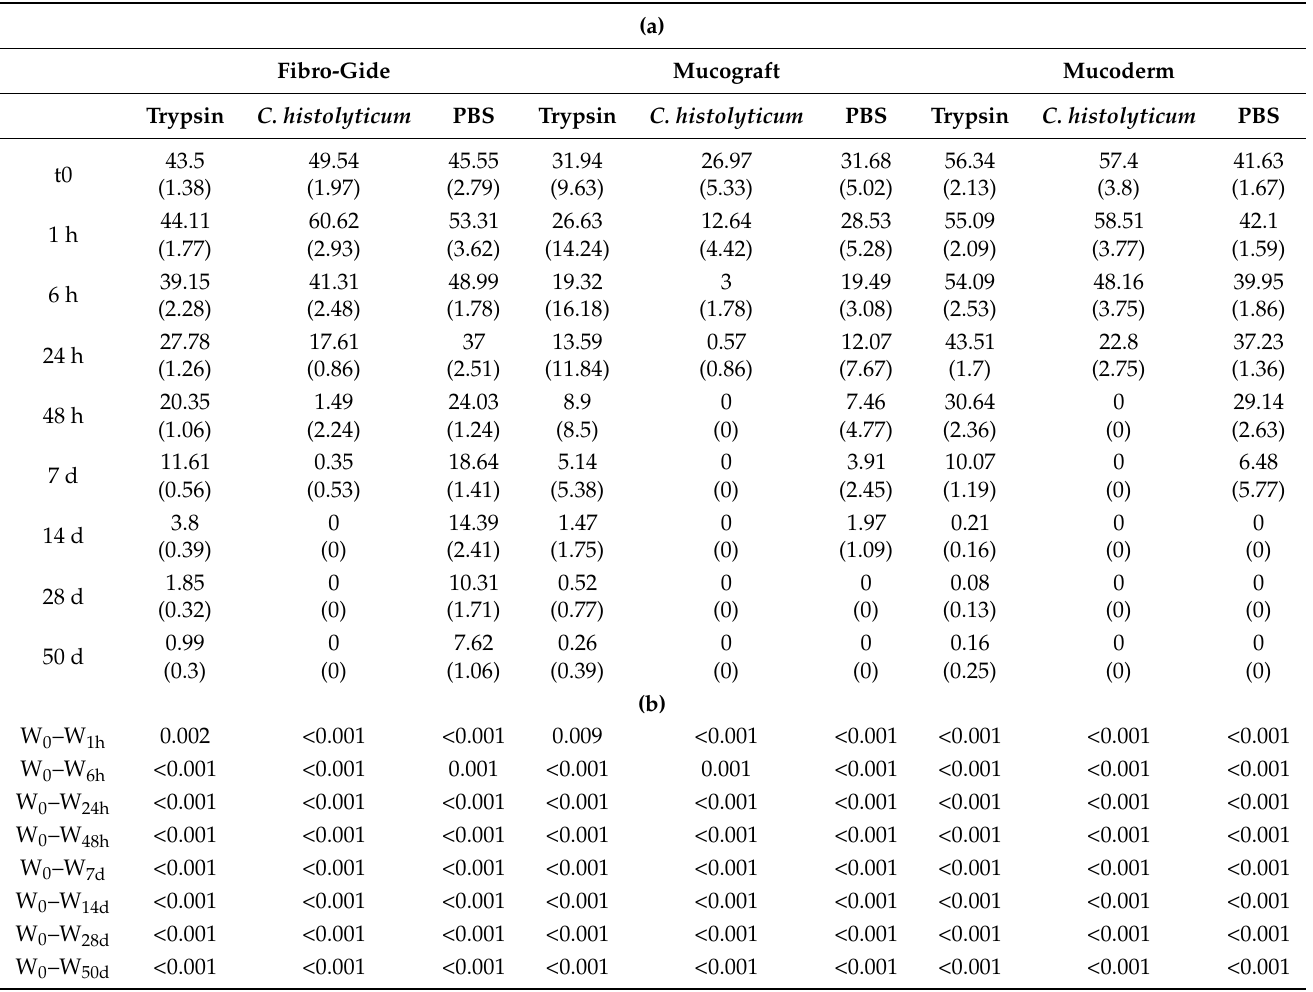
Table 3. ( a ) Weight values ( µ g) of the three experimental matrices (Fibro-Gide, Mucograft and Mucoderm) after different immersion periods ranging from 1 h to 50 days in the different degradation tests; PBS (hydrolytic degradation